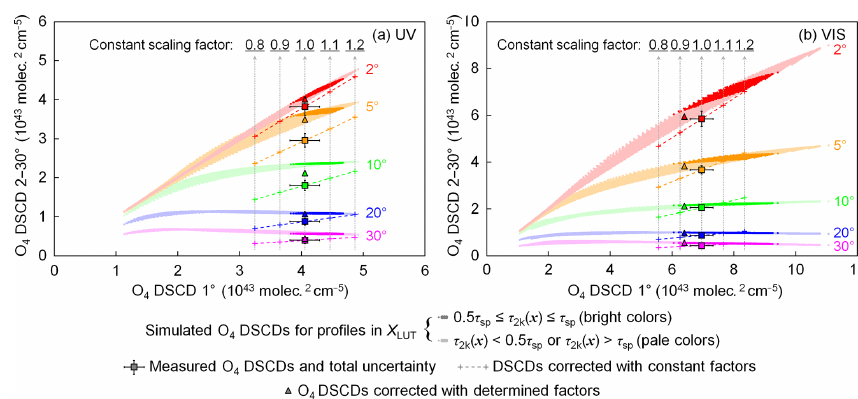
Figure 7. Distribution of simulated, measured, and corrected O 4 DSCDs in the (a) UV and (b) VIS bands of the scanning cycle on 7 Decem- ber 2015 at ∼ 13:55UTC (SZA ∼ 79 ◦ , RAA ∼ 39 ◦ ). The x axes indicate the O 4 DSCDs measured (or simulated) at the elevation angle of 1 ◦ , while y axes represent the O 4 DSCDs measured (or simulated) at other elevation angles. Different colors indicate measurements at different elevation angles. The colored dots show the simulated O 4 DSCDs of all the possible profiles in the profile set ( X LUT ). The data points of the profiles with AOD between 0 and 2km ( τ 2k ( x ) ) vary between 50% and 100% of the total AOD measured by the sun photometer ( τ sp ,λ ) and are shown in bright colors, while the dots of the other profiles are shown in pale colors. The square markers represent measured O 4 DSCDs (corrected for the systematic errors caused by the topography simplification), and the error bars show the total uncertainties. The plus signs along the dashed lines show the measured O 4 DSCDs corrected with constant factors of 0.8, 0.9, 1.1, and 1.2. The triangle markers show the measured O 4 DSCDs corrected with the finally determined scaling factors listed in Table 6.